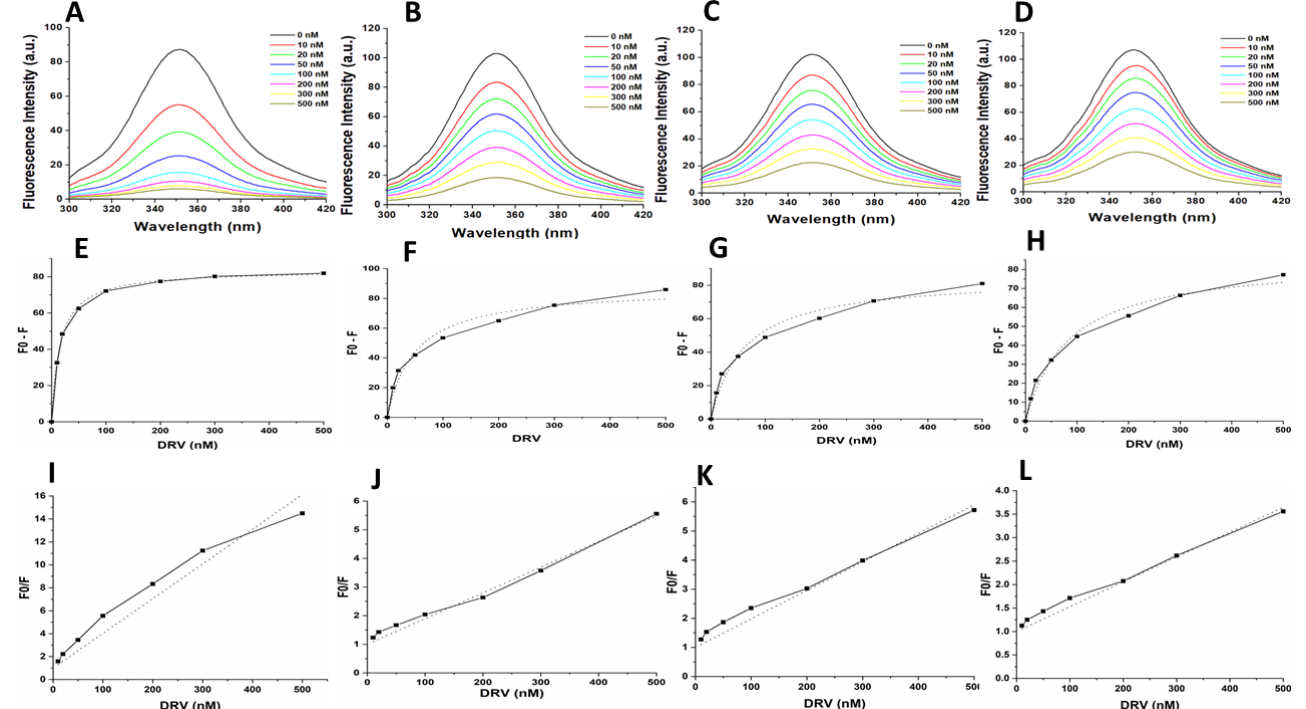
Figure 6. ( A – D ) Intrinsic tryptophan fluorescence quenching using DRV for the WT, MUT-1, MUT-2, and MUT-3 respectively. ( E – H ) Change in intrinsic tryptophan fluorescence for determination of K i using DRV for the WT, MUT-1, MUT-2, and MUT-3 respectively. ( I – L ) Stern–Volmer plot to determine the quenching constants ( K sv ) using DRV for the WT, MUT-1, MUT-2, and MUT-3 respectively. Table 2. Inhibition constant (K i ) and Stern–Volmer quenching constants ( K sv ) calculated from fluorescence quenching